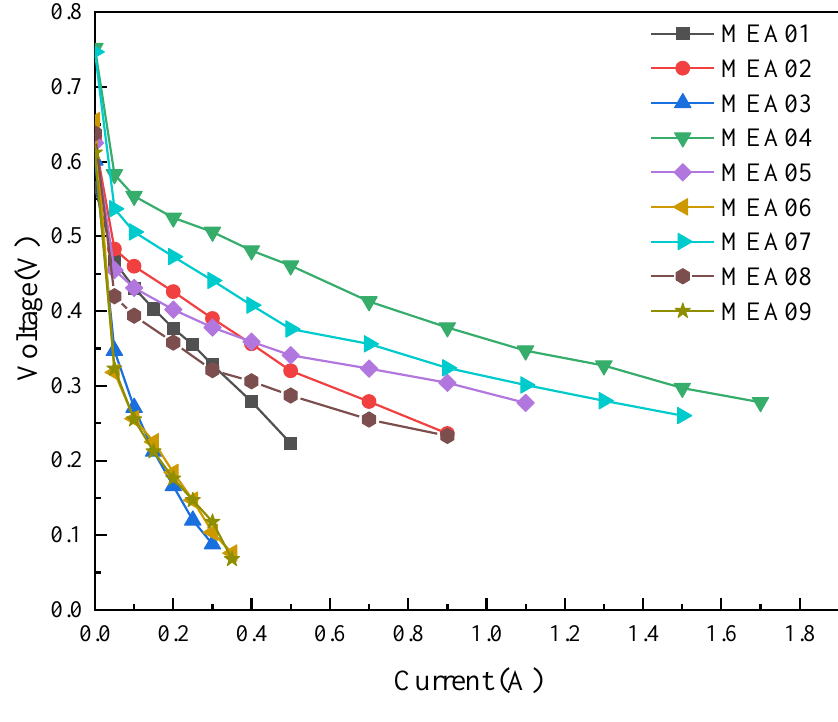
Figure 3. Polarization curves.